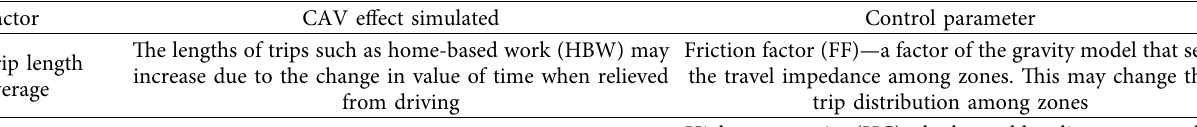
Table 2: FDOT adjustments for